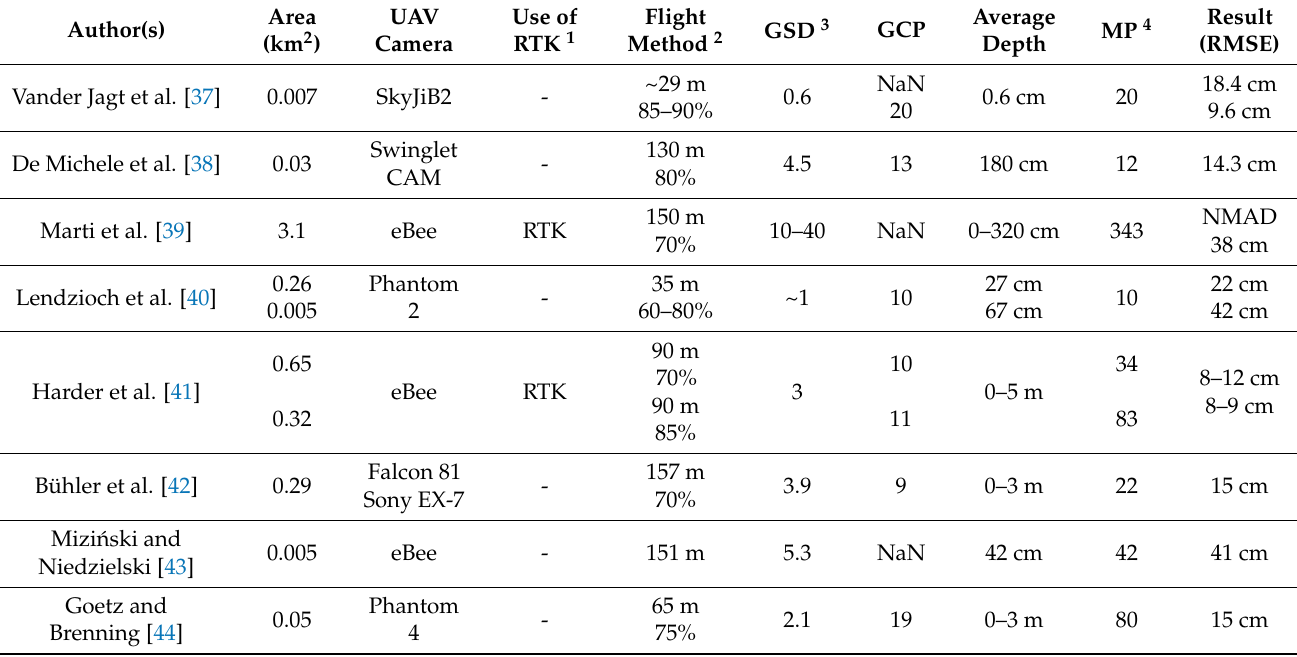
Table 1. Summary of the studies that estimated snow depth using the UAV-photogrammetry